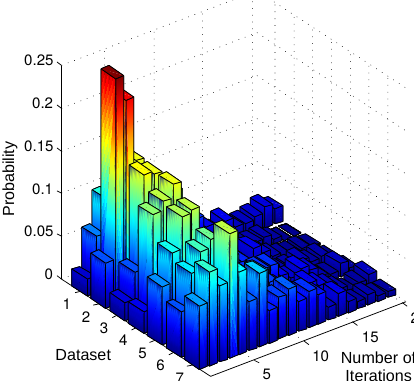
Figure 10. Distributions of the number of iterations required for the convergence of the algorithm.